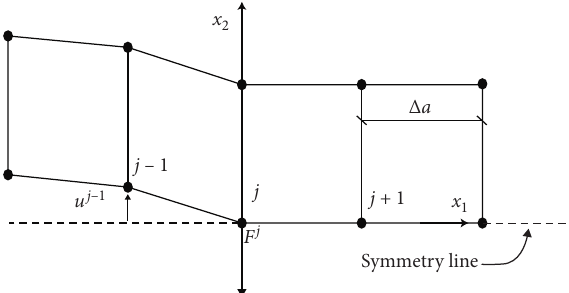
Figure 8: Schematic of MCCI technique for 4